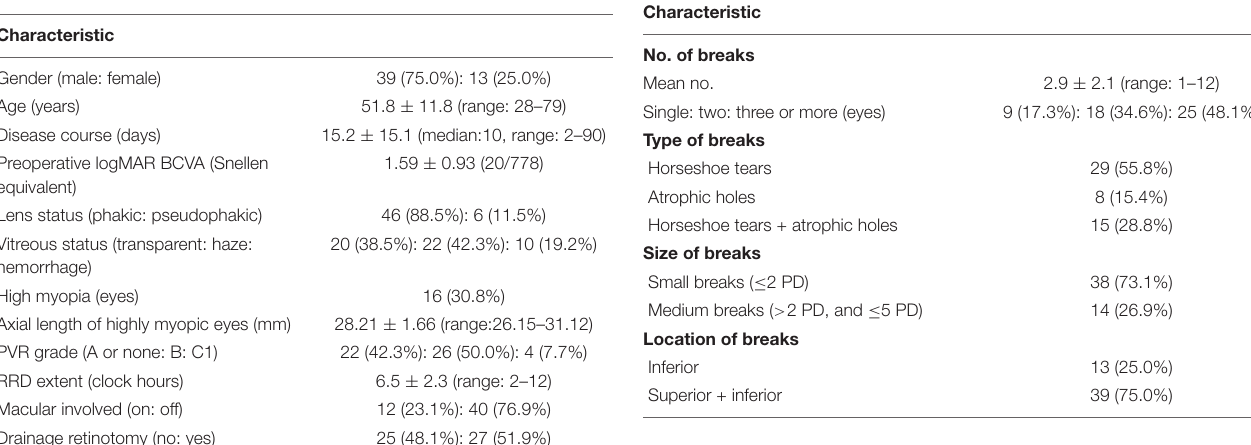
TABLE 3 | Clinical characteristics of patients with primary reattachment